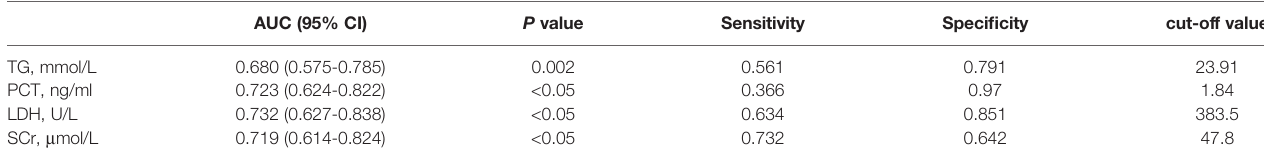
TABLE 6 | The cut off values of TG, Scr, PCT, and LDH for POF under the receiver operating characteristic curve.